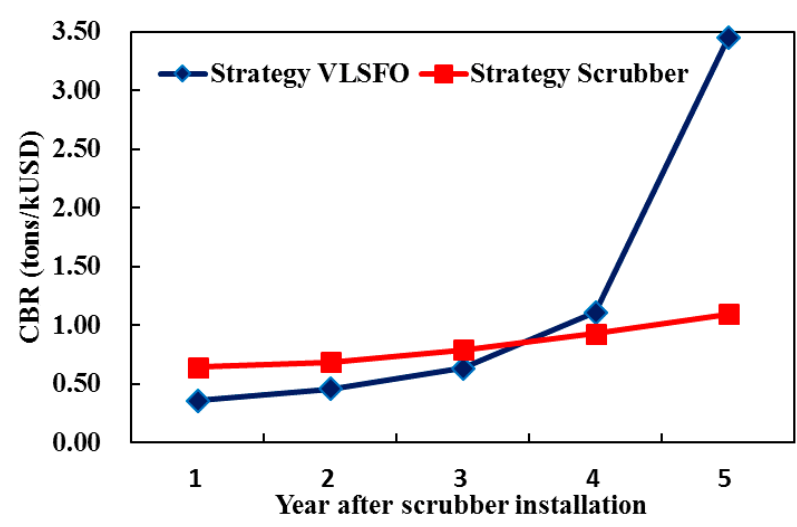
Figure 5. Cost-benefit ratios of Strategy VLSFO and Strategy Scrubber.